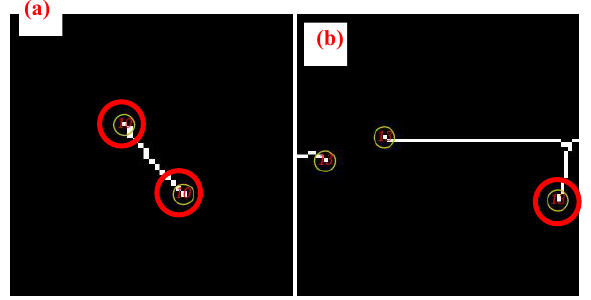
Figure 4. Schematic diagram of invalid breakpoints